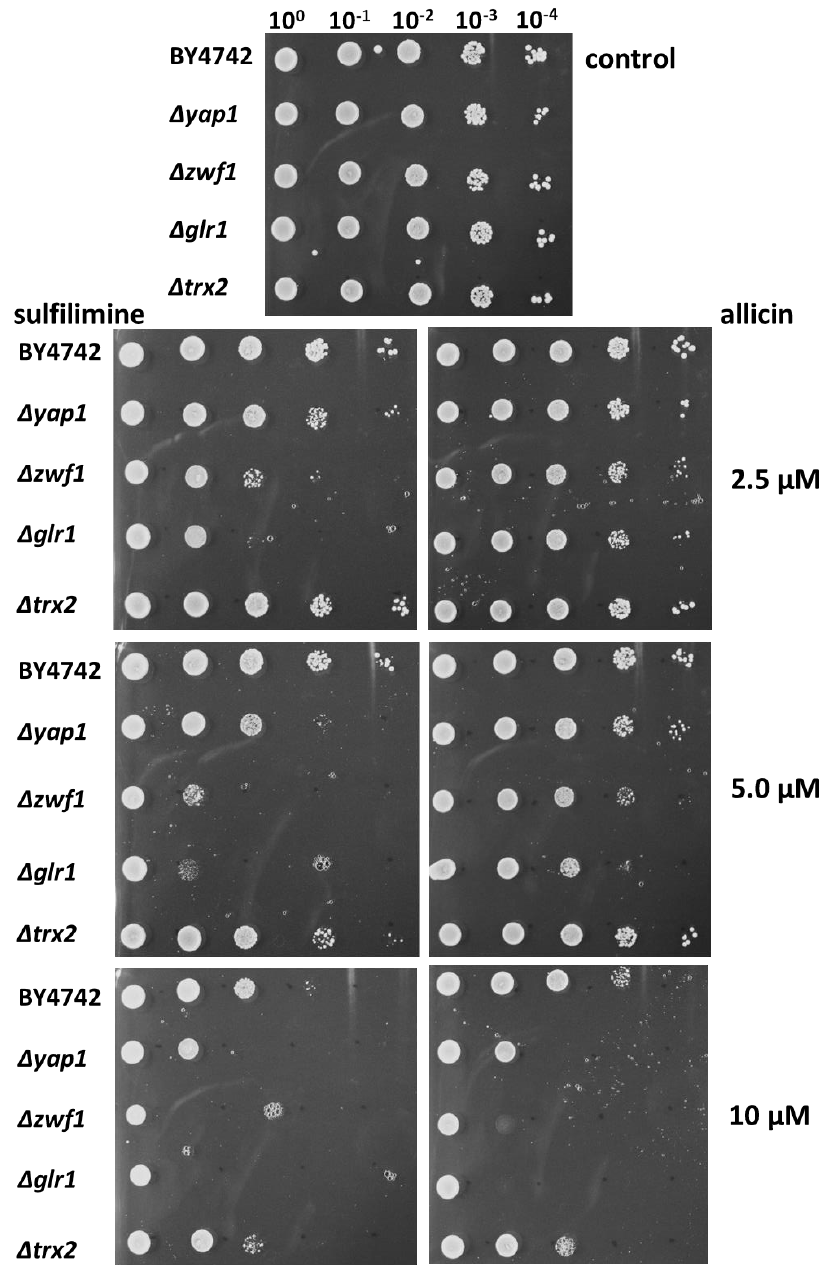
Figure 3. Chemogenetic screen of CSA ( S -allyl- S -( S -allyl)- N -cyanosulfilimine) and allicin against a serial dilution of selected yeast mutants in a drop